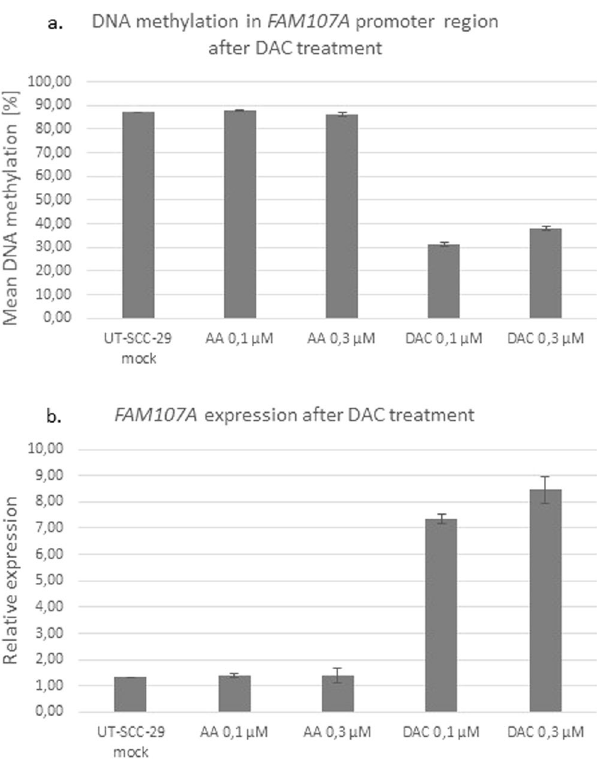
Figure 4. FAM107A DNA methylation ( a ) and mRNA expression ( b ) after DAC treatment (demethylation).